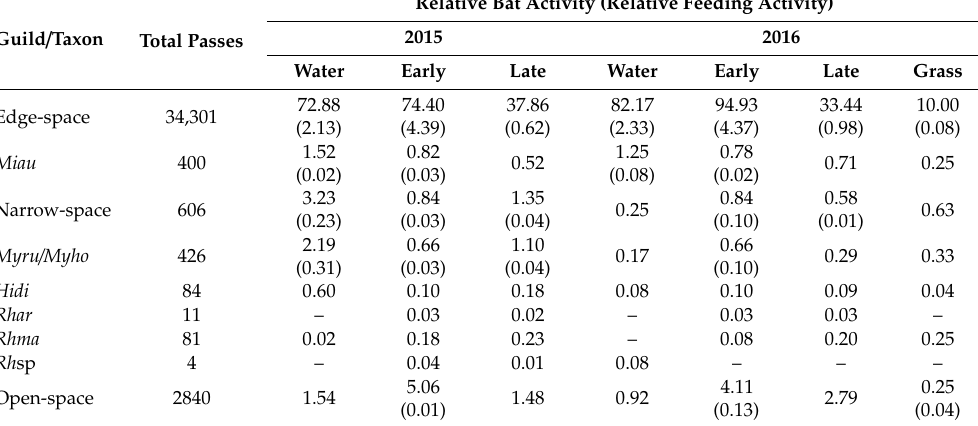
Table 2. Total bat passes recorded from ground level, relative bat activity (total no. bat passes / no. hours) and relative feeding activity (total no. buzzes / no. hours) by rice growth stage for each guild and acoustically distinct taxa within each guild. Water = tilled and water-filled paddy pre-planting, Early = seedling and early vegetative (i.e., canopy < 50%), Late = late vegetative (i.e., canopy > 50%), Grass = grass-filled fallow paddy. Species abbreviations as in Table